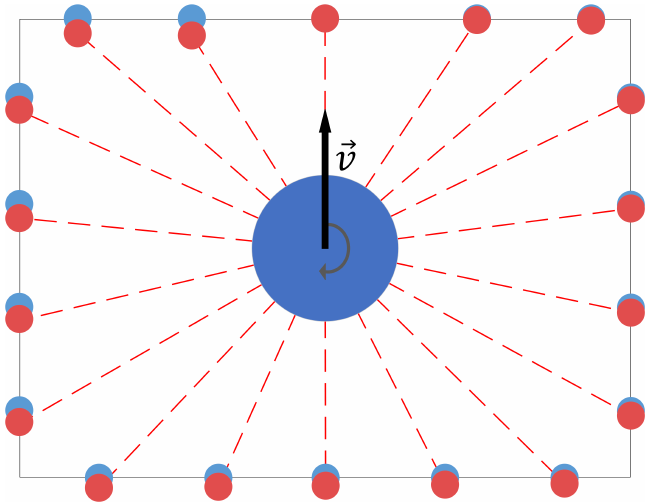
Figure 4. Illustration of point cloud motion distortion in a simple room seen from the top view. Raw point cloud in red; undistorted points in